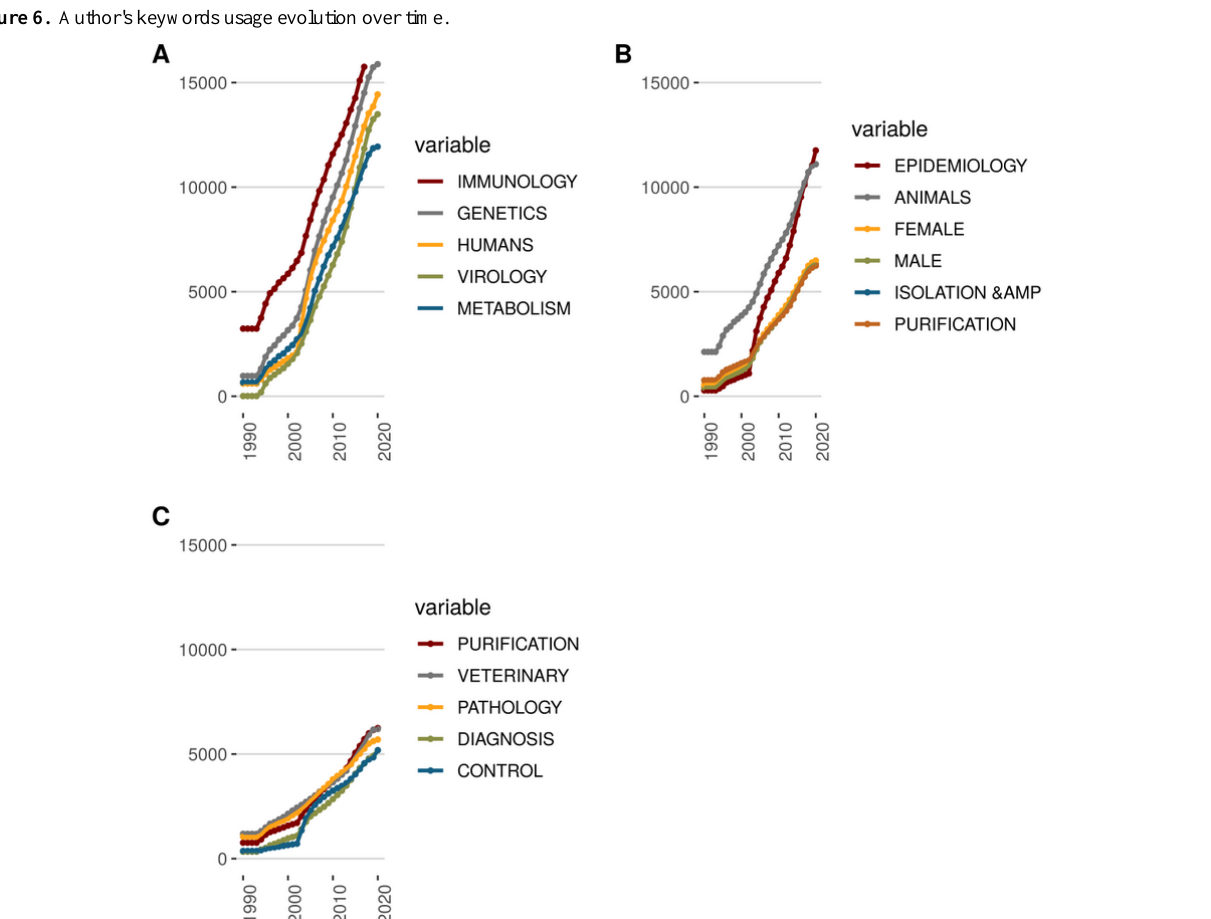
Figure 6. Author's keywords usage evolution over